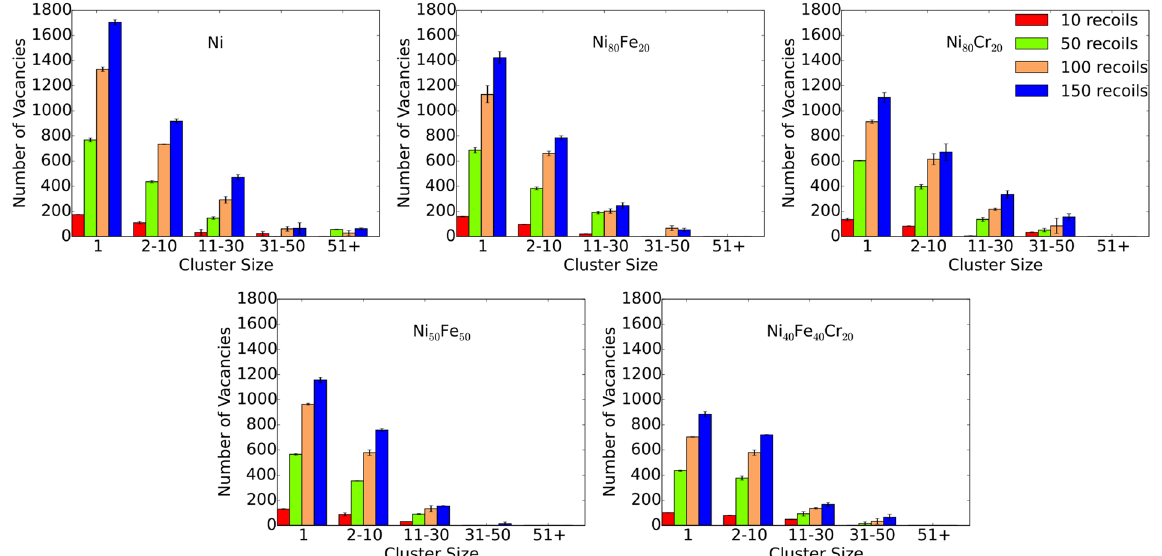
Figure 6. Vacancy cluster size distribution at different recoil events. Comparison of vacancy cluster size distribution between Ni, Ni